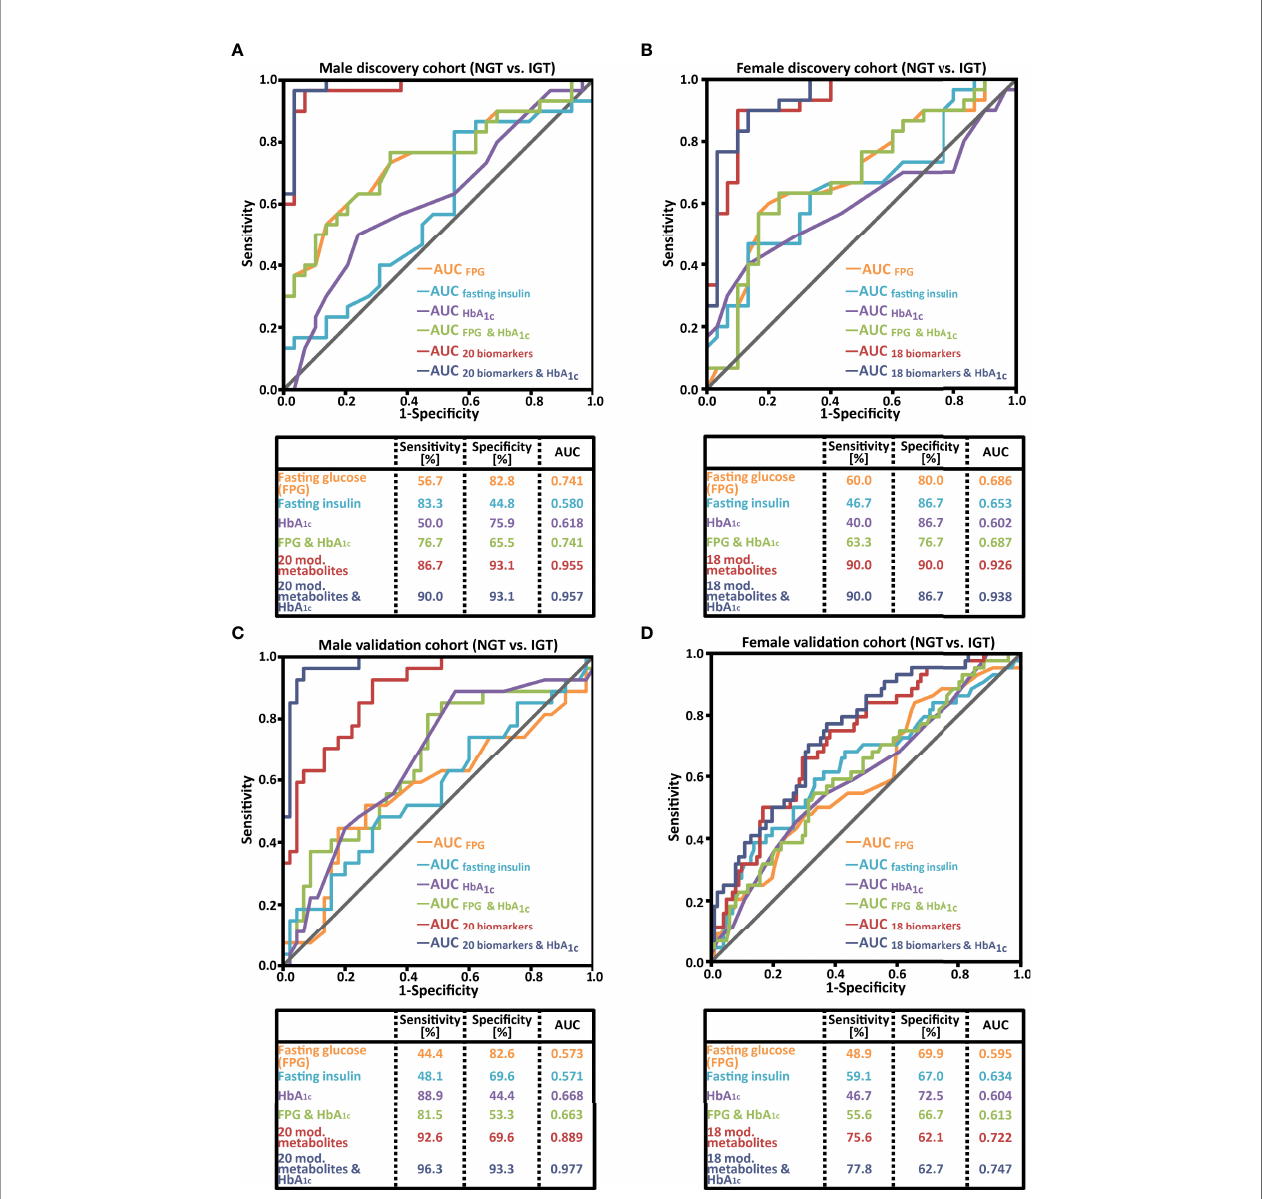
FIGURE 3 | Receiver operating characteristic (ROC) curve analysis comparing the performance of a sex-speci fi c biomarker pattern with common prediabetes laboratory parameters of (A) the male discovery cohort; (B) the female discovery cohort; (C) the male validation cohort; (D) the female validation cohort. NGT, normal glucose tolerant; IGT, impaired glucose tolerant, AUC, area under the ROC